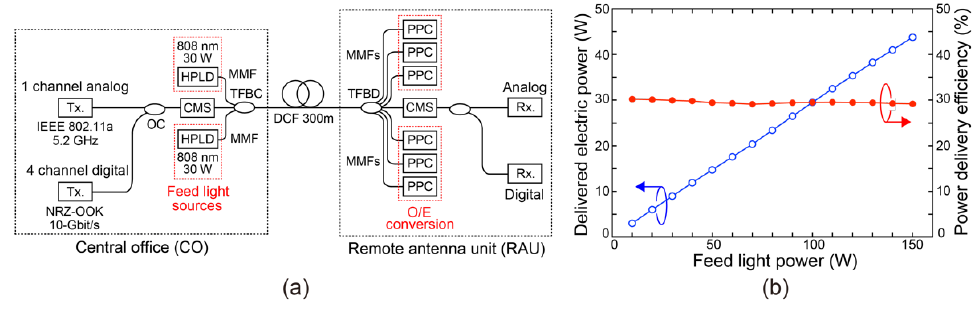
Figure 6. ( a ) Configuration of optically powered remote antenna unit using a DCF [8]. ( b ) Character- istics of 43.7 W delivered electric power of PWoF system [42].